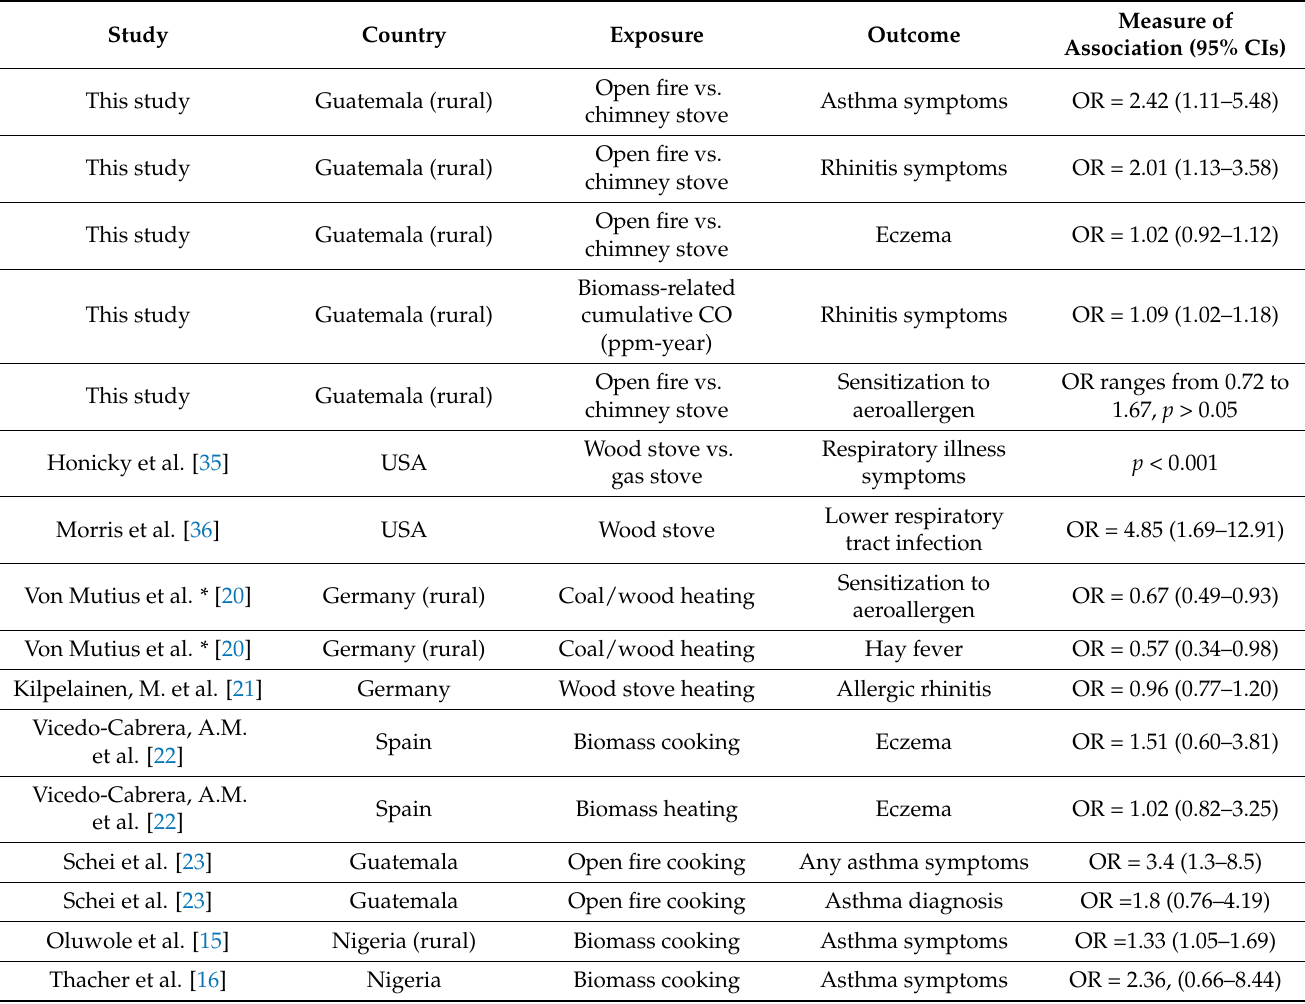
Table A2. Summary of results from studies on household biomass smoke exposure and allergic or respiratory outcomes in pediatric